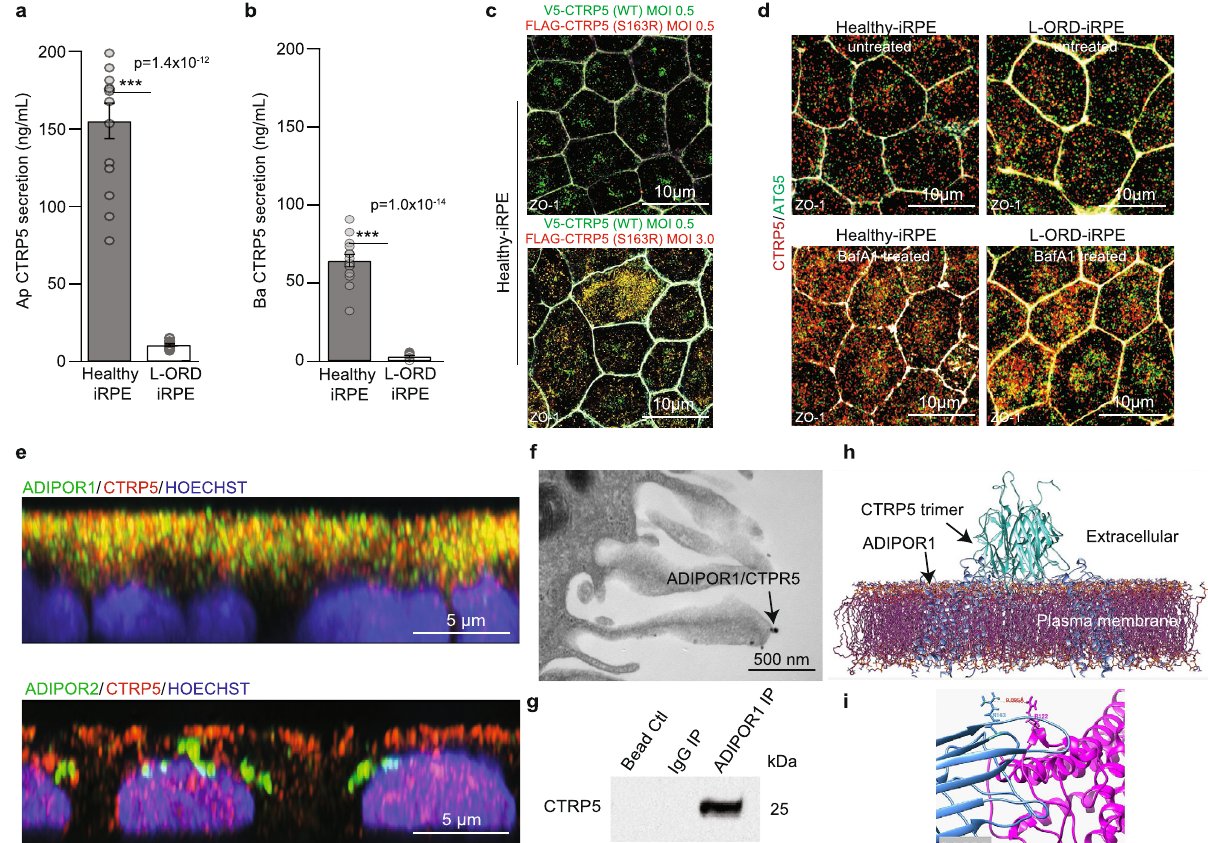
Fig. 2 Expression and localization of CTRP5 in L-ORD-iRPE. a , b Apical and basal CTRP5 secretion measured by ELISA in the culture medium are both signi fi cantly decreased ( n = 14). c Coexpression of V5-tagged WT CTRP5 (green) and FLAG-tagged S163R CTRP5 (red) in healthy-iRPE. V5-tagged WT CTRP5 expressing lentivirus construct was transduced at MOI 0.5 for both top and bottom panels. MOI of Flag-tagged S163R CTRP5 expressing lentivirus construct was 0.5 for cells in the top panel and 3.0 for cells in the bottom panel. Scale bar: 10 µ m d Confocal microscopy images of untreated and ba fi lomycin (BafA1) treated (3 h) healthy-iRPE and L-ORD-iRPE co-stained with CTRP5 (red) and ATG5 (green). ( n = 3 images per condition). Scale bar: 10 µ m. e Representative confocal microscopy images showing colocalization of CTRP5 (red) with membrane receptors ADIPOR1 (green, upper panel) and no colocalization with ADIPOR2 (green, lower panel). Nuclear stain (blue). Scale bar: 5 µ m. f TEM image of immunogold labeled ADIPOR1 (6 nm gold particle) and CTRP5 (12 nm gold particle) demonstrate the co-binding of two proteins (arrow). Scale bar: 500 nm. g Western blot detects CTRP5 in the membrane fraction of iRPE cells immunoprecipitated using anti-ADIPOR1 antibodies and not in lanes immunoprecipitated with the IgG antibody or with only beads. h Probabilistic model of the interaction of integral membrane protein ADIPOR1 (blue) and CTRP5 (teal) determined using